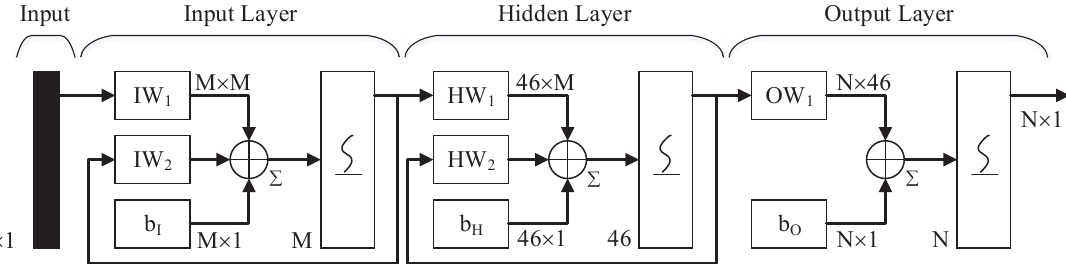
Figure 3. There are three layers in the Elman neural network. The neurons of input layers are determined by the number of input features. The output layers are decided by the classification. The hidden layer contains 46 neurons as